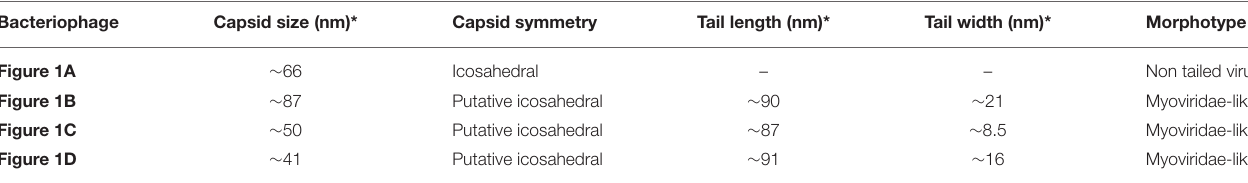
* All reported measures were obtained from negative-stained